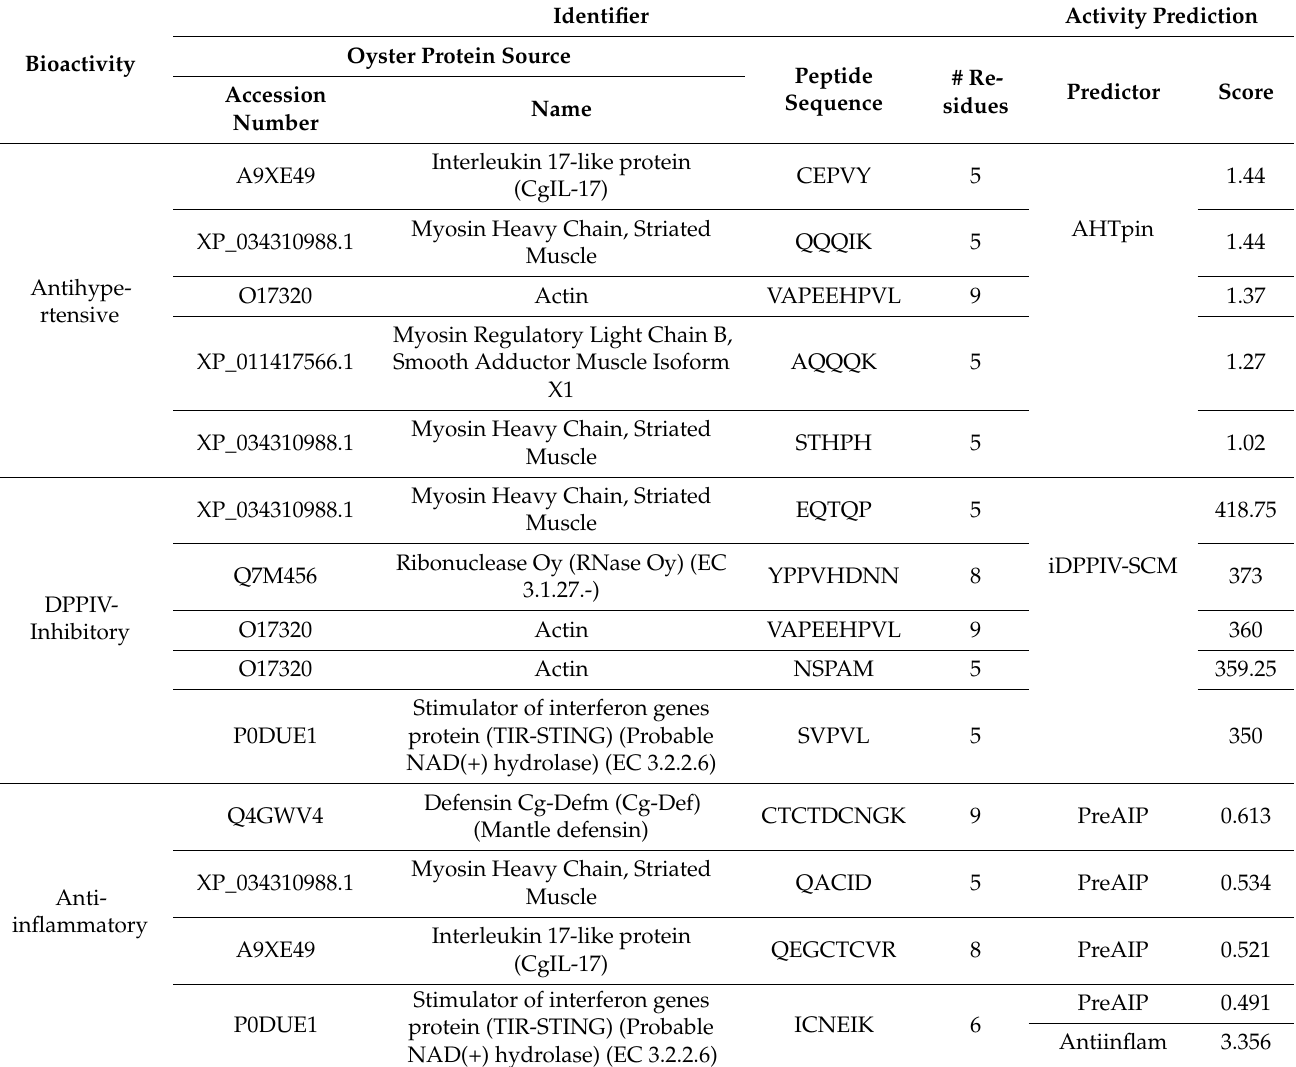
Table 3. Top C. gigas bioactive peptide candidate shortlist with bioactivity prediction